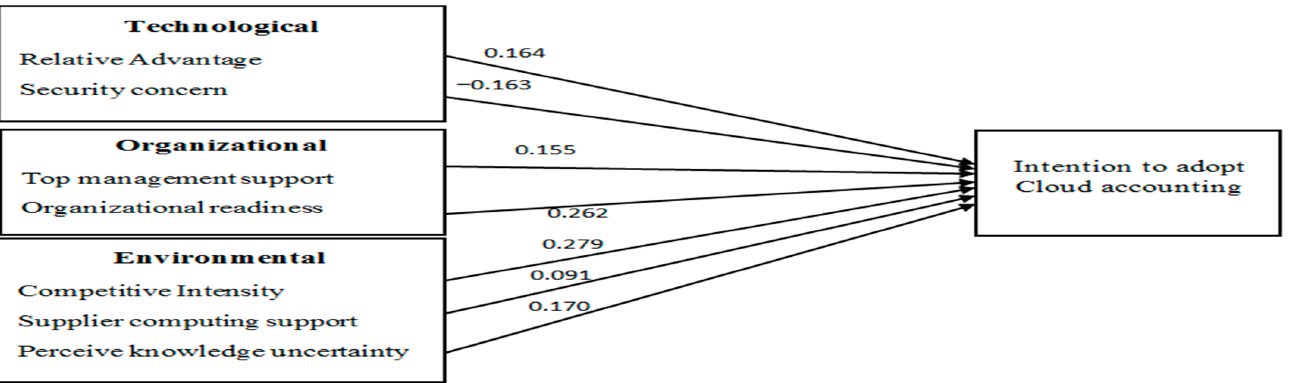
Figure 2. Results of path coefficient.